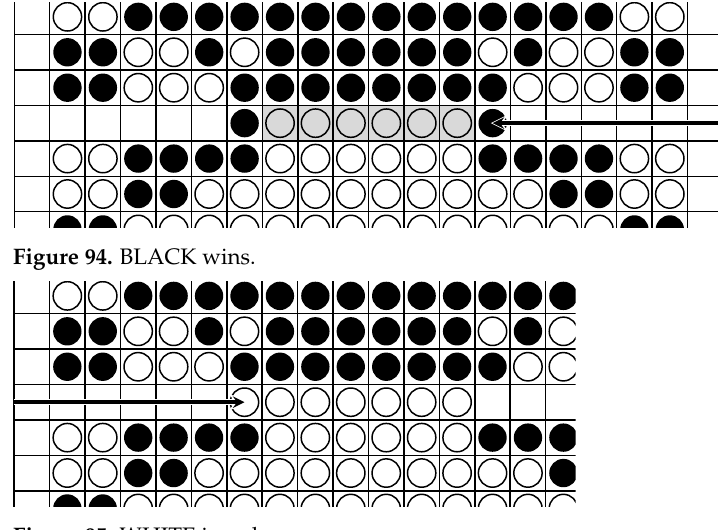
Figure 95. WHITE invades.